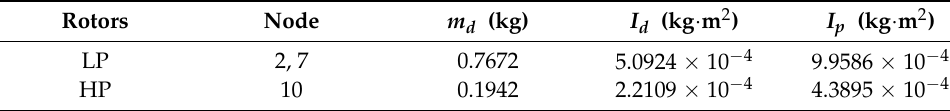
Table 2. Disk parameters for the dual-rotor-bearing system.